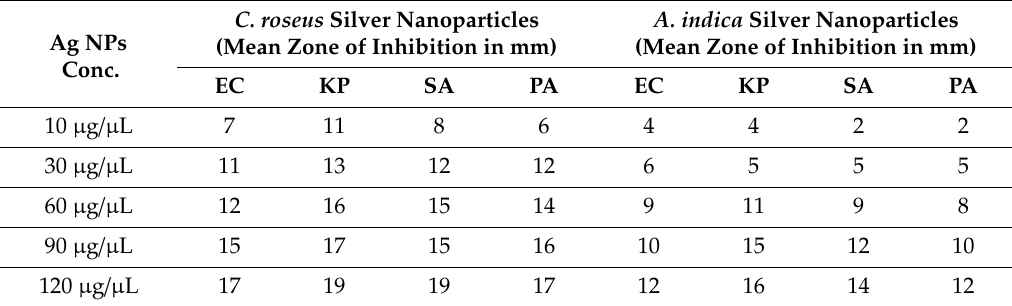
Table 1. Antibiotic susceptibility test of MDR bacteria and the zone of inhibition for different concentrations of green-synthesized silver nanoparticles.